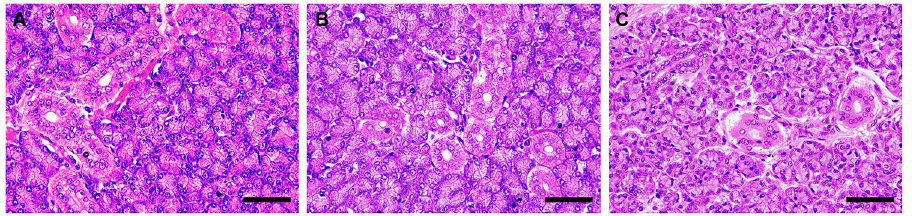
Fig 8. Histopathological analysis. Evaluation of morphological changes in the parotid glands of mice (n = 30, 10 per group) exposed for 60 days to F concentrations: 0 mg/L, 10 mg/L and 50 mg/L. Photomicrographs of sections stained in Hematoxylin and Eosin. A 0 mg/L, B 10 mg/L and C 50 mg/L. Scale bar: 50 μ m.